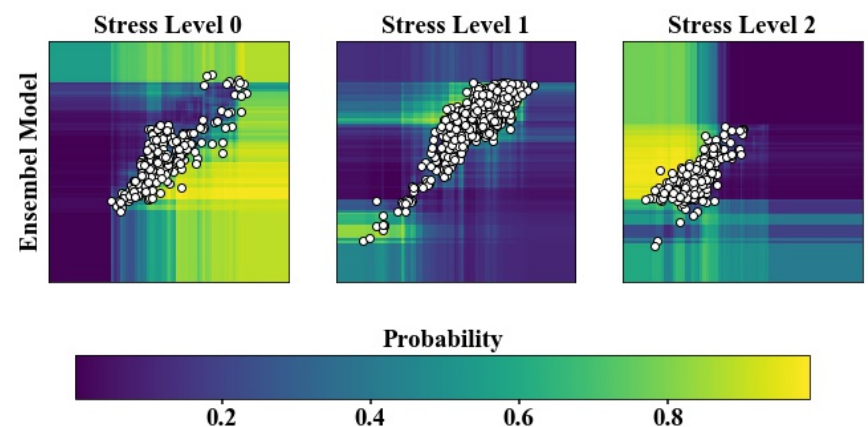
Figure 12. The probabilities that rice pixels belong to different stress classes for the ensemble model.